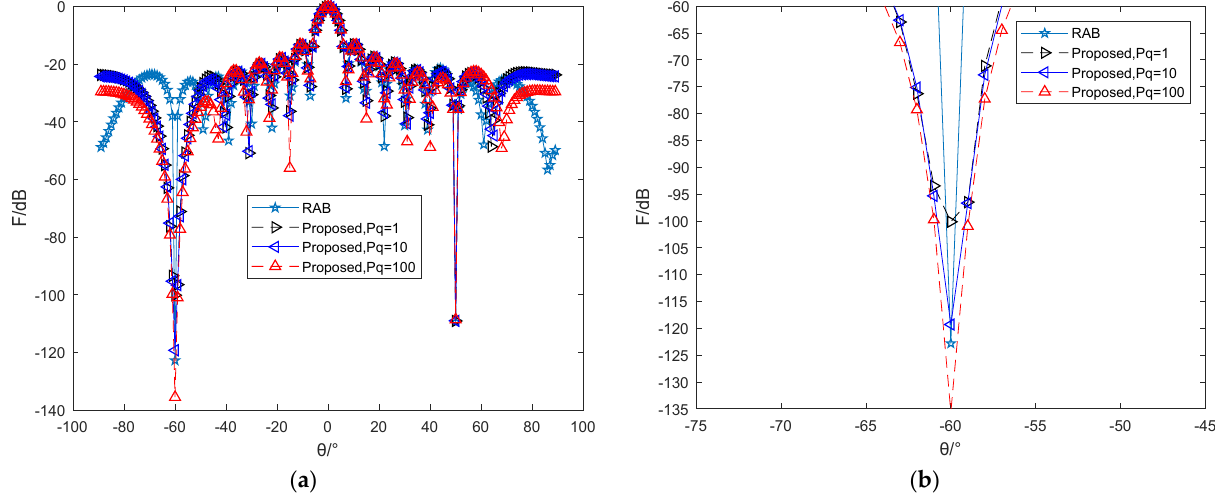
Figure 3. Comparison of null depth: ( a ) overall pattern, ( b ) local enlarged drawing.